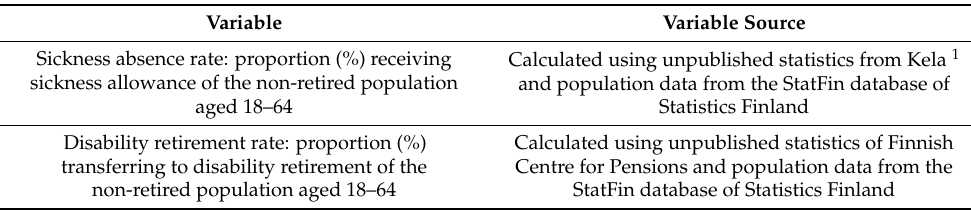
Table A1. Sources of the municipality-level